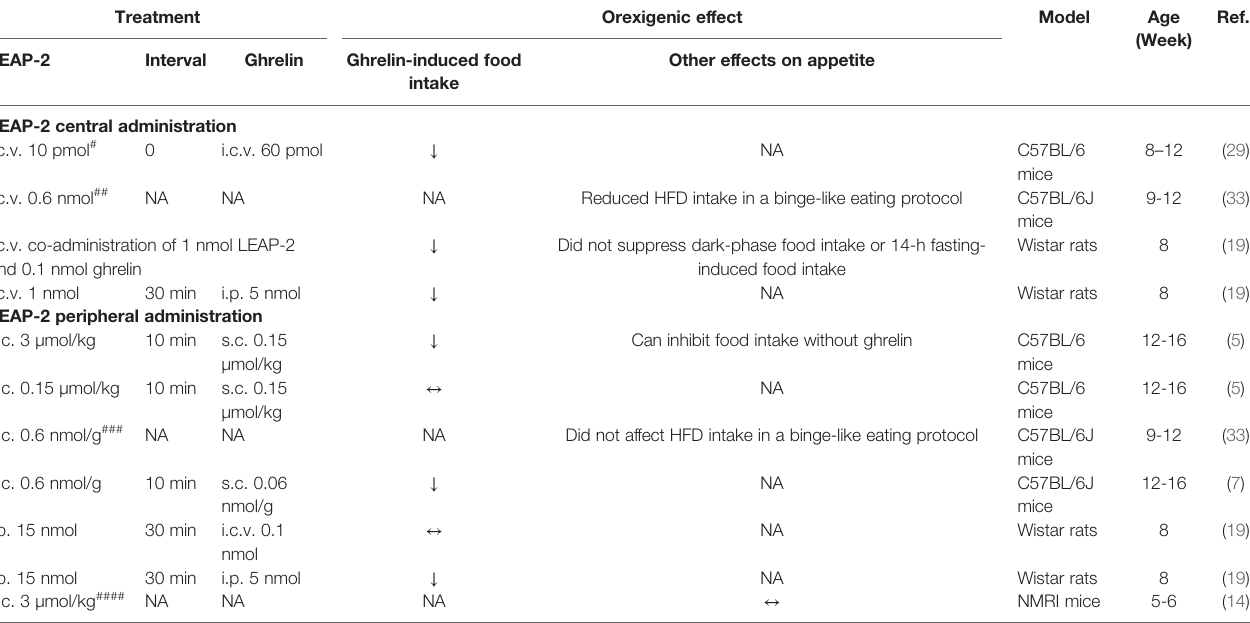
TABLE 1 | The effect of LEAP-2 on food intake based on experiments carried out from 2018 to 2021. Treatment Orexigenic effect